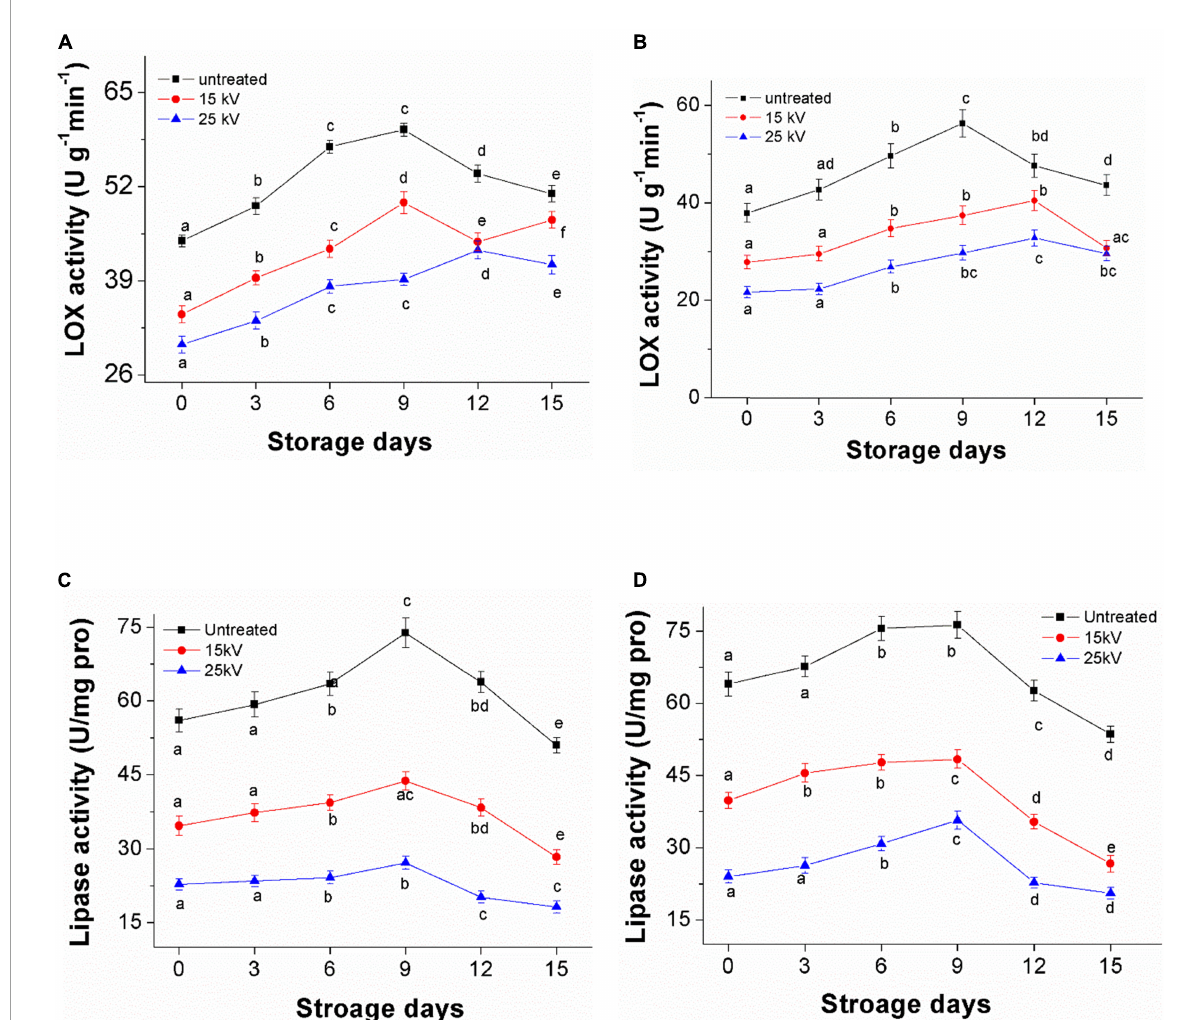
FIGURE7 Changes of LOX and lipase activity of foxtail millet during accelerated aging storage. (A,C) Mizhi. (B,D) Ansai.